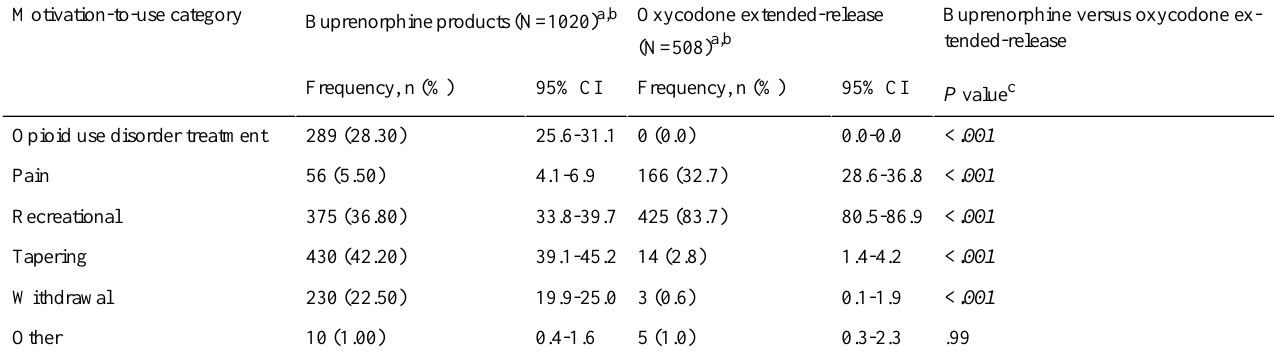
Table 4. Percentage of posts mentioning specific motivation-to-use categories and Chi-square P values for pairwise differences.